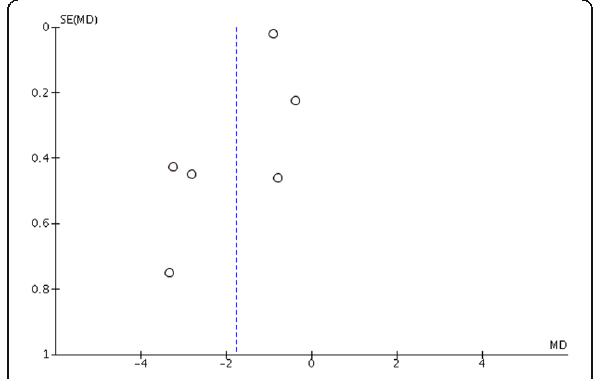
Fig. 6 Funnel plot for anchorage loss in the vertical dimension (MD mean difference, SE standard